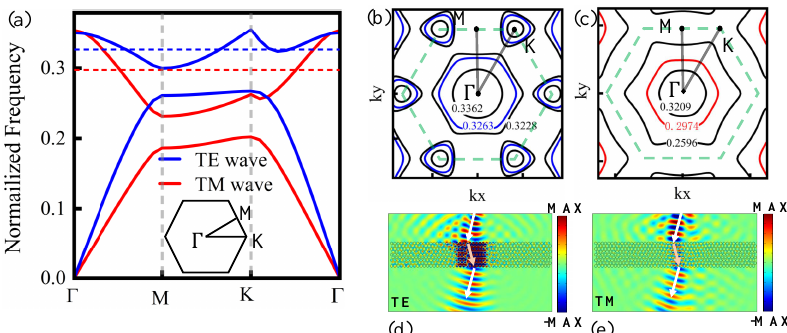
Figure 2. ( a ) Photonic band structure of the PxC with silicon rods in air, with TM and TE modes denoted by the red and blue lines, respectively. The red and blue dashed lines correspond to the normalized frequencies of 0.3263(c/a) and 0.2974(c/a). EFCs of the second band for ( b ) TE and ( c ) TM modes. ( d ) Negative refraction of the TE mode at the frequency of 0.3263(c/a). ( e ) Negative refraction of the TM mode at the frequency of